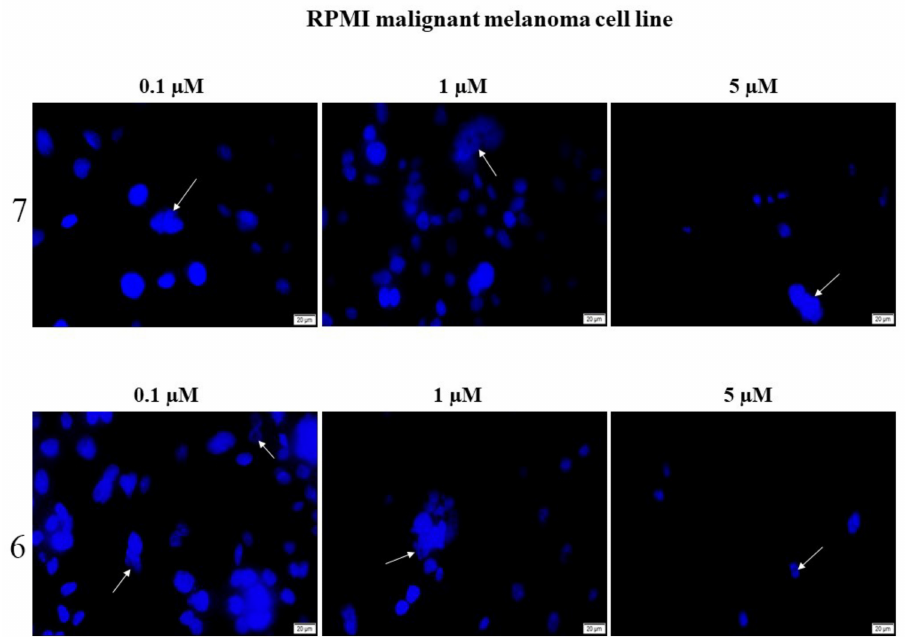
Figure 7. Effect of compounds 6 and 7 (0.1, 1, and 5 uM) and DMSO (0.1, 1, and 5 uM) after 24 h of stimulation on the RPMI—DAPI staining. The white arrows indicate the apoptotic cells with nuclear fragmentation; figures are scaled at 20 µ